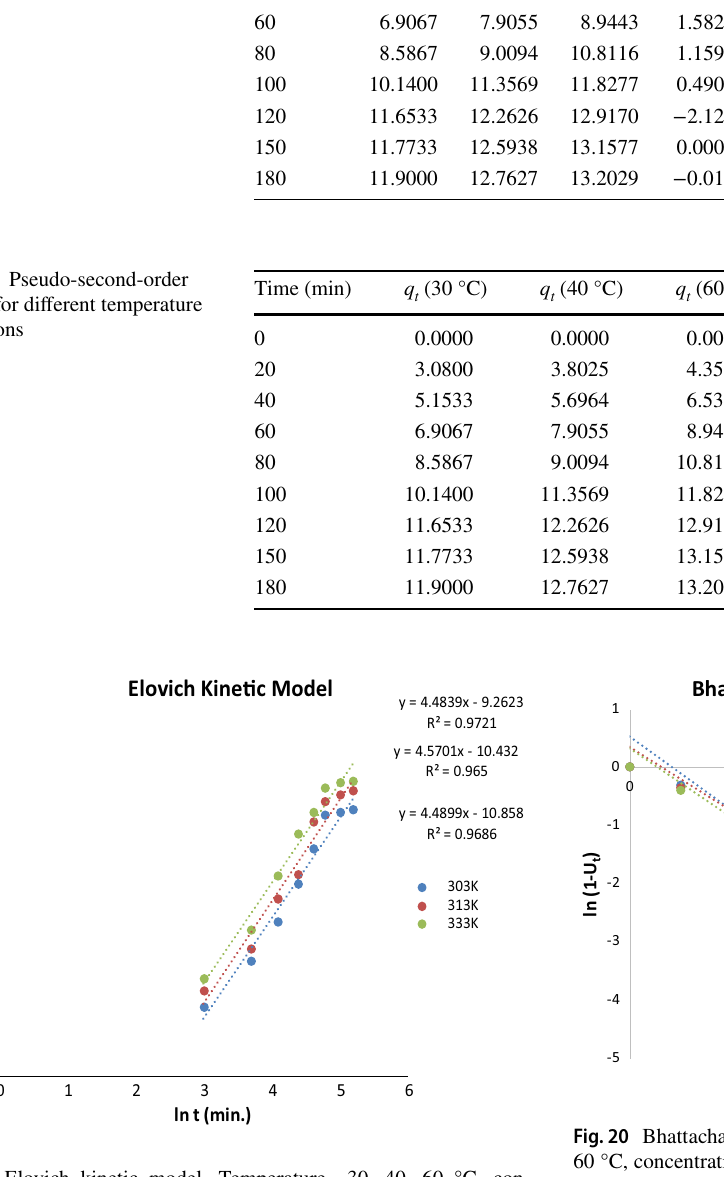
Fig. 19 Elovich kinetic model. Temperature—30, 40, 60 °C, con- centration—20 ppm, time—180 min, rpm—100, adsorbent dose— 150 mg, volume—100 ml